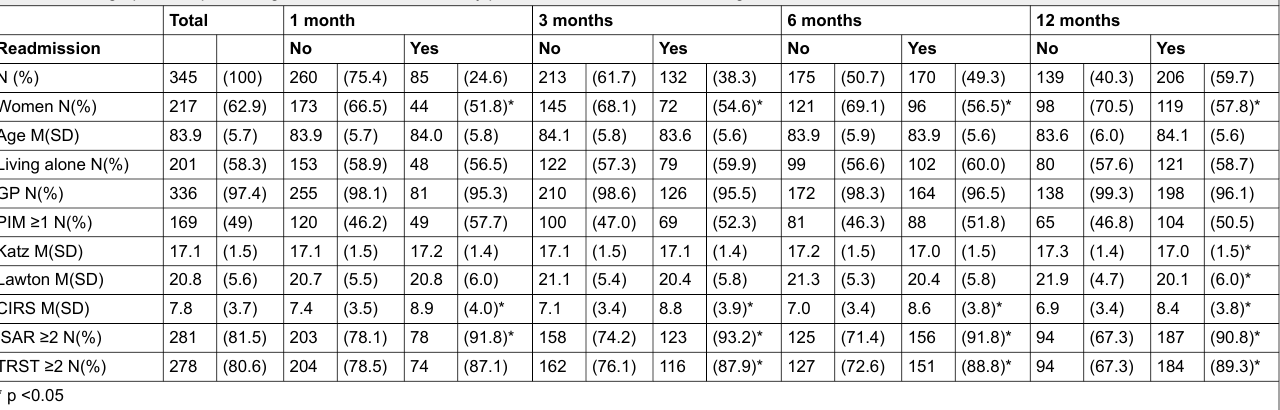
Table 1: Demographic and presenting characteristics of the study patients at baseline and according to their readmission at 1, 3, 6 and 12 months. Total 1 month